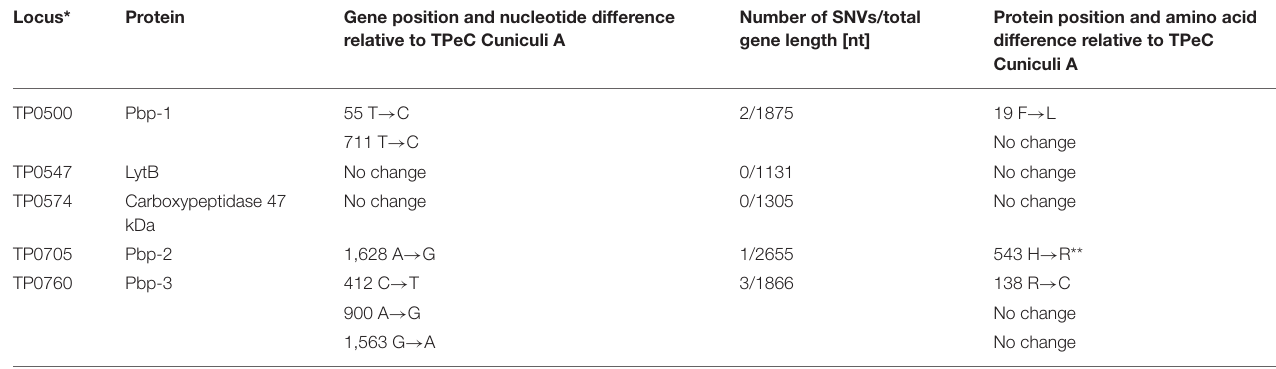
TABLE 1 | Sequences of TP0500, TP0547, TP0574, TP0705, and TP0760 loci that encode the penicillin-binding proteins in TPeC Cz-2020. Locus* Protein Gene position and nucleotide difference relative to TPeC Cuniculi A